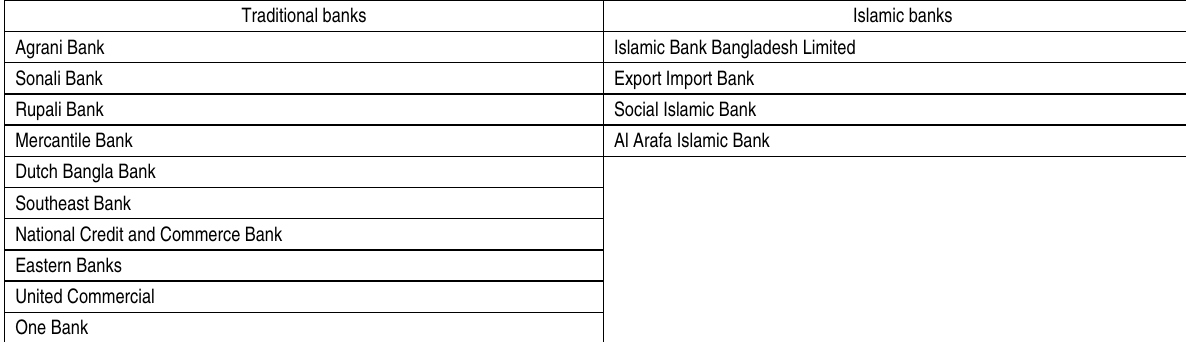
Table A. A list of sample banks